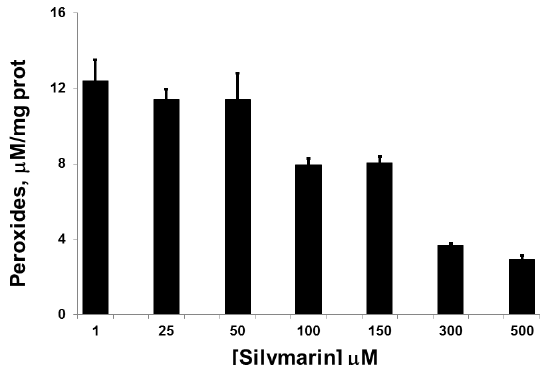
Figure 1. Levels of intracellular peroxides in HIT-T15 cells incubated in the presence of glucose